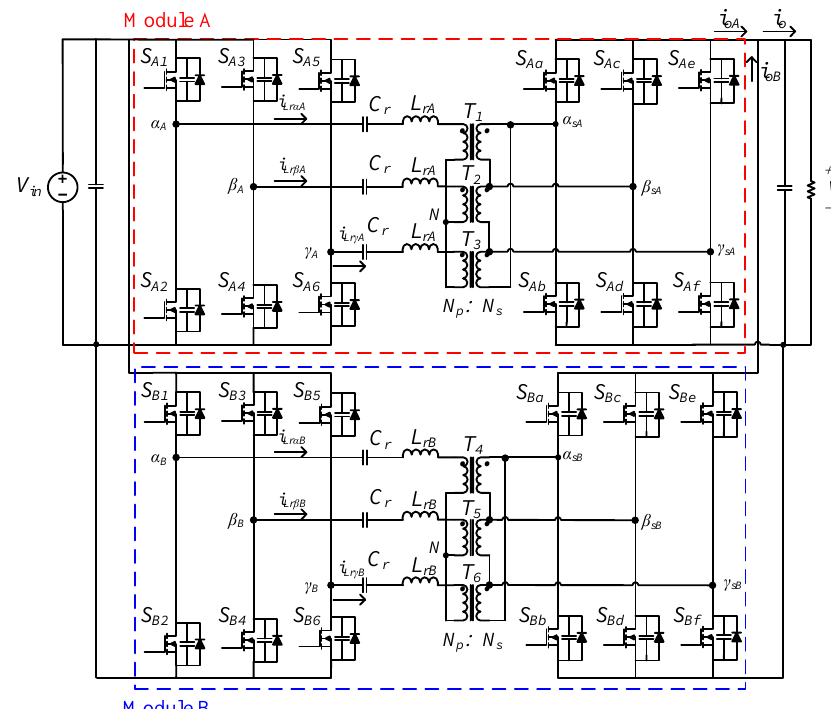
Figure 6. Schematic of an interleaved three-phase series-resonant converters (SRC).